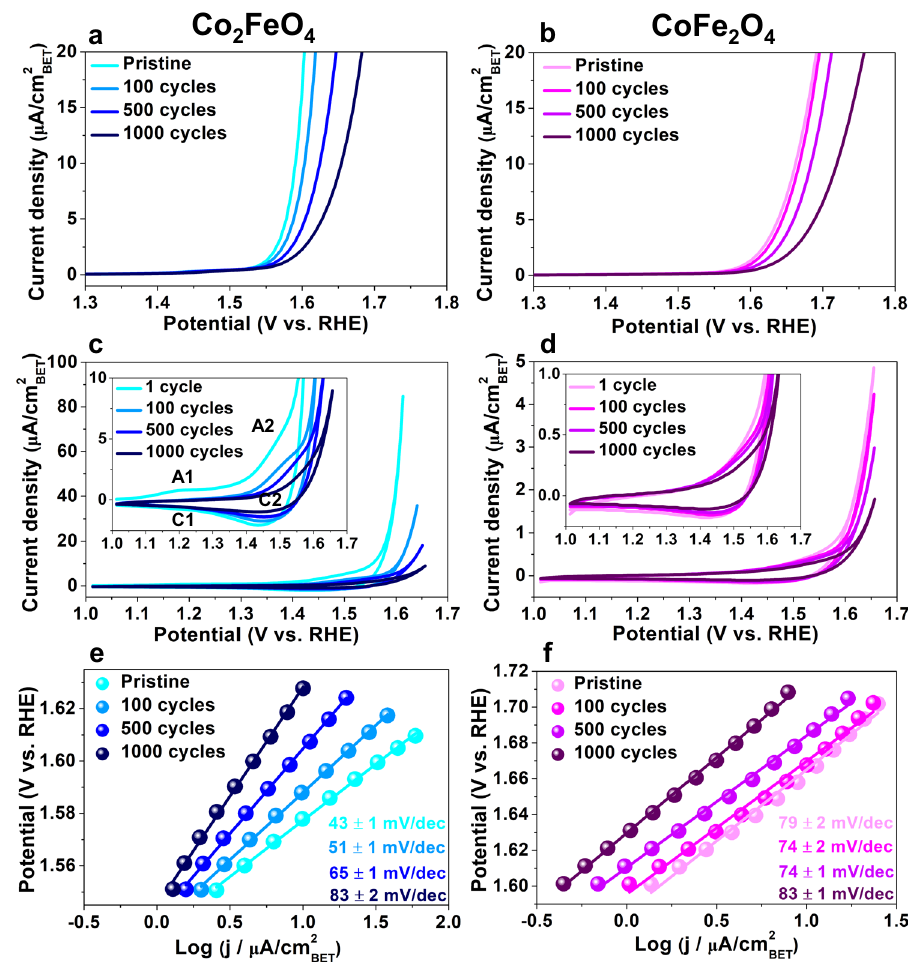
Fig. 1 OER activity of Co 2 FeO 4 and CoFe 2 O 4 nanoparticles. a , b Linear sweep voltammetry (LSV) curves recorded at a scan rate of 10 mV/s in 1.0 M KOH on glassy carbon electrodes deposited with Co 2 FeO 4 and CoFe 2 O 4 nanoparticles in the pristine state and after 100, 500 and 1000 cycles of cyclic voltammetry (CV) measurements, c , d CVs of Co 2 FeO 4 and CoFe 2 O 4 after one, 100, 500 and 1000 cycles recorded at a scan rate of 50 mV/s in 1.0 M KOH under OER conditions, e , f Tafel slopes of Co 2 FeO 4 and CoFe 2 O 4 in the pristine and after 100, 500 and 1000 cycles, derived from the LSV curves in a , b . Source data are provided as a Source Data fi le. The error bars of Tafel slopes in e , f were measured by linear curve fi